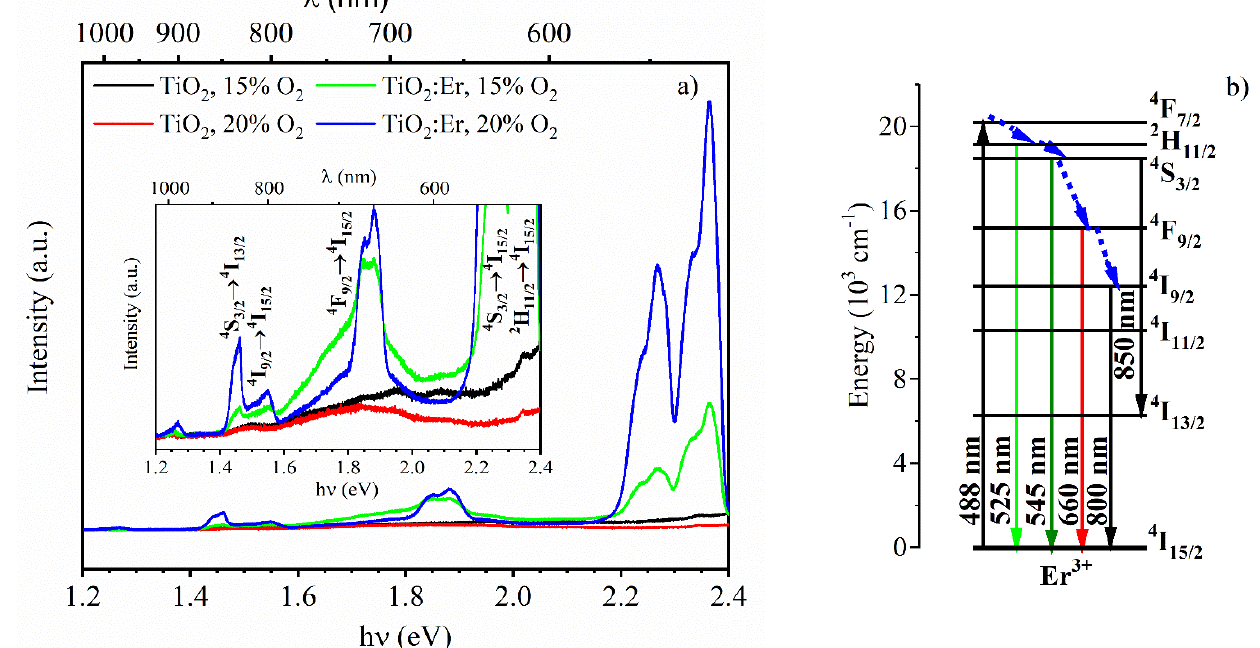
Figure 11. ( a ) Luminescence spectrum of pure TiO 2 and Er-doped TiO 2 thin films deposited at 15 and 20% of O 2 (enlargement in the inset) excited with 488 nm laser; ( b ) simplified diagram of possible transitions in Er 3+ .